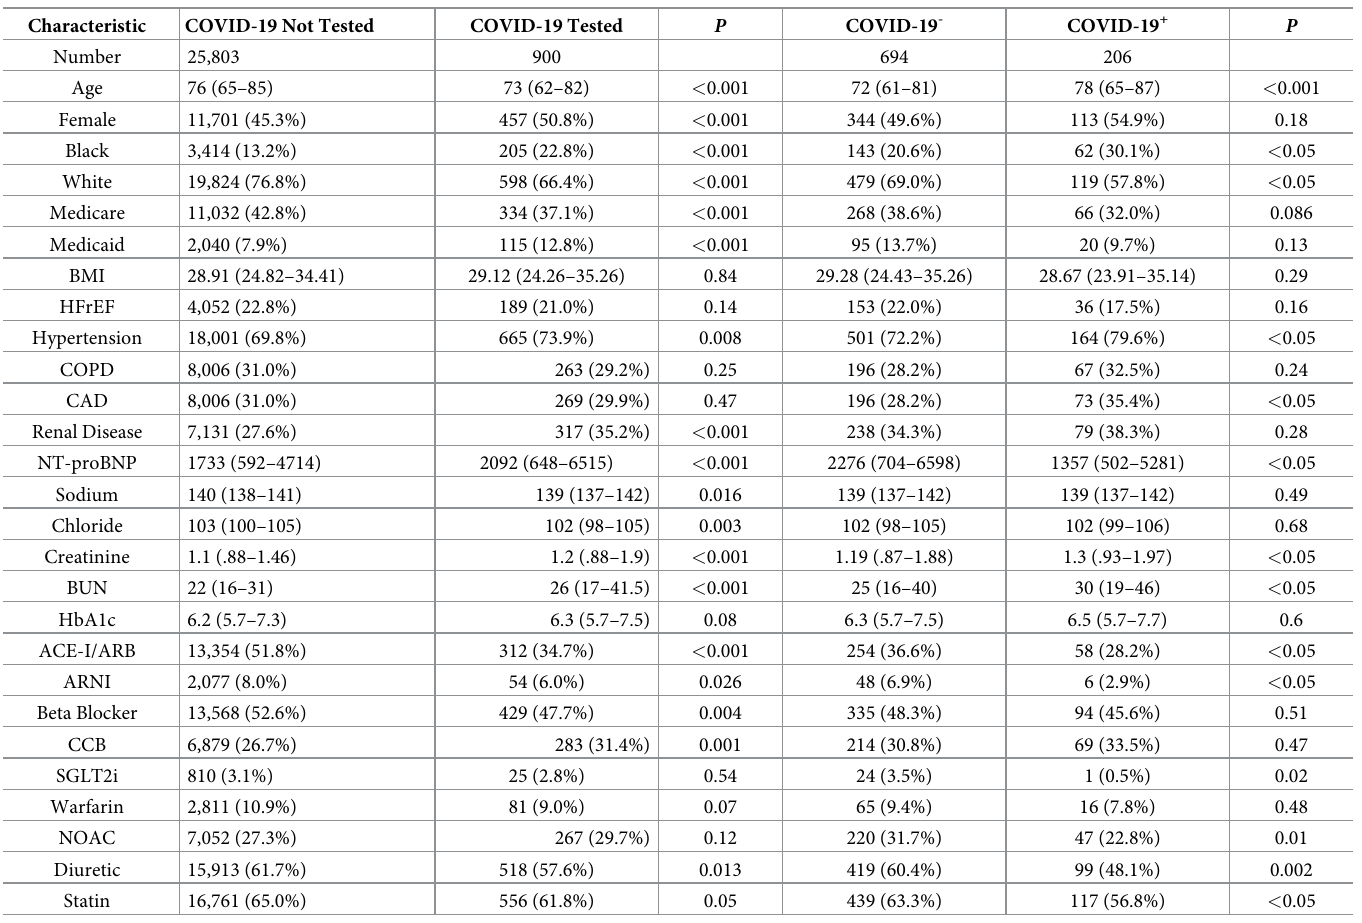
Table 1. Baseline clinical characteristics of patients according to testing